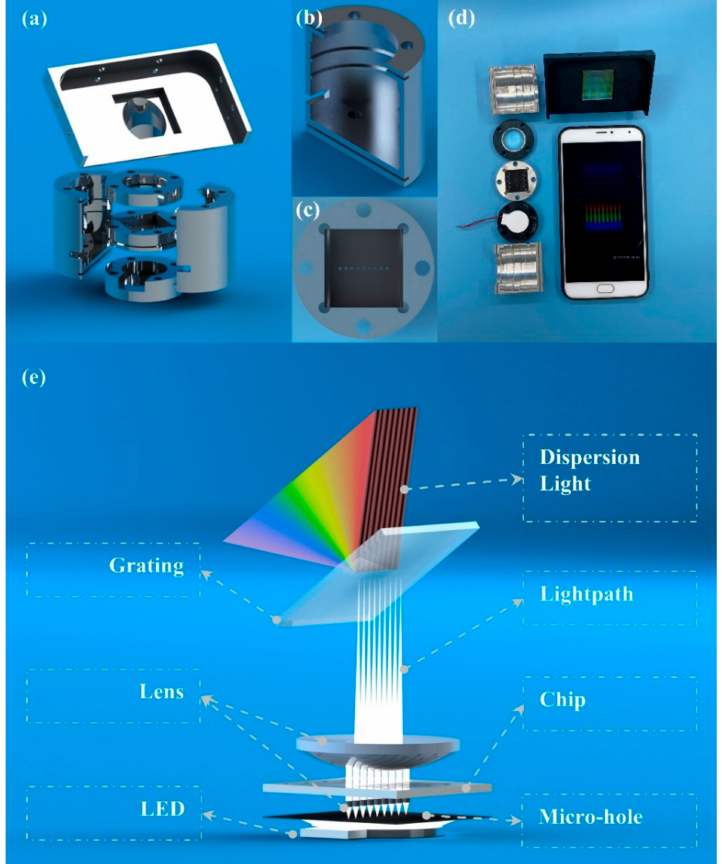
Figure 2. Schematic of attachments of the SBSM (smartphone biosensor system with the multi-testing-unit). ( a ) The schematic of attachments; ( b ) The detail of the case; ( c ) The detail (top view) of the stage of micro-hole array and small-lens array; ( d ) The picture of attachments and the smartphone; ( e ) The working principle of the